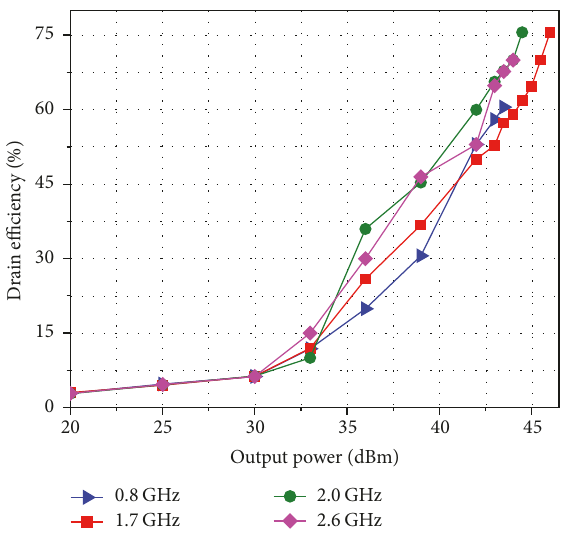
Figure 9: Measured and simulated output power, drive efficiency, and gain versus frequency.